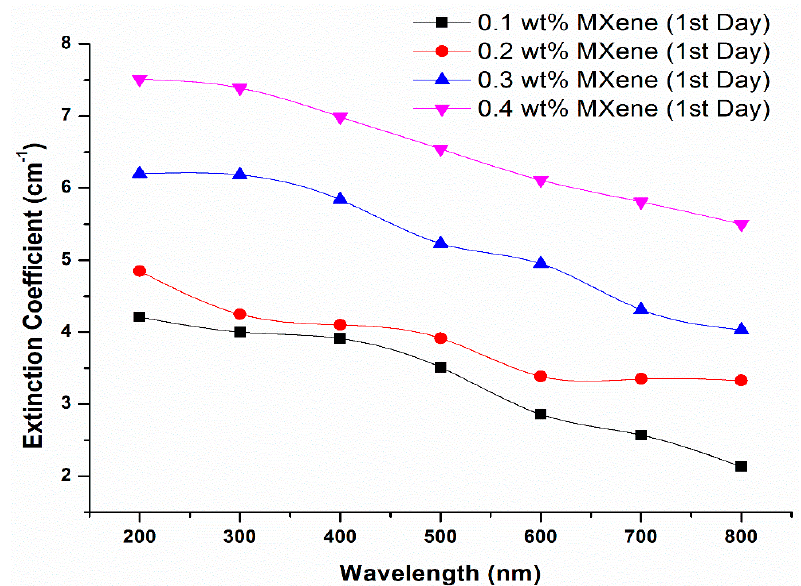
Figure 10. E ff ect of nanoparticle concentration towards extinction coe ffi cient on the first Figure 10. Effect of nanoparticle concentration towards extinction coefficient on the first day.